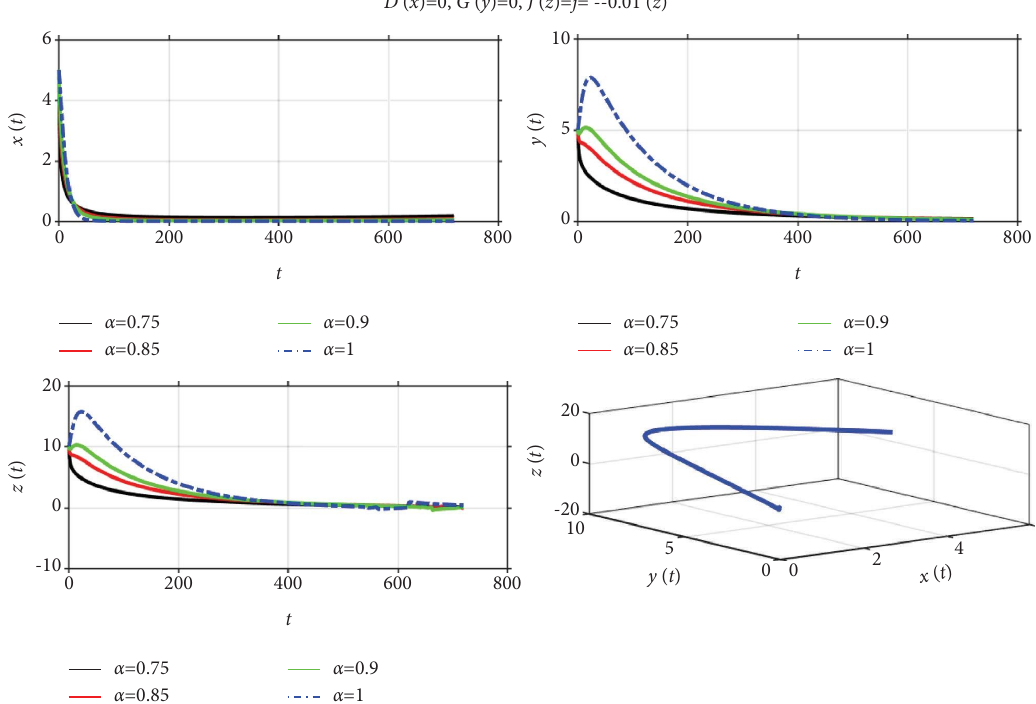
Figure 12: Population dynamics of the one prey-two predators system with D ( x ) � 0 , G ( y ) � 0 , J ( z ) � − j / z � − 0 . 01/ z, a � b � c � 0 . 1 , e � h � 0 . 3 , f � i � 0 . 2 , α � 0 . 75 , 0 . 85 , 0 . 9 , 1 , and 3D-plot of x ( t ) , y ( t ) , and z ( t ) for α � 1 .